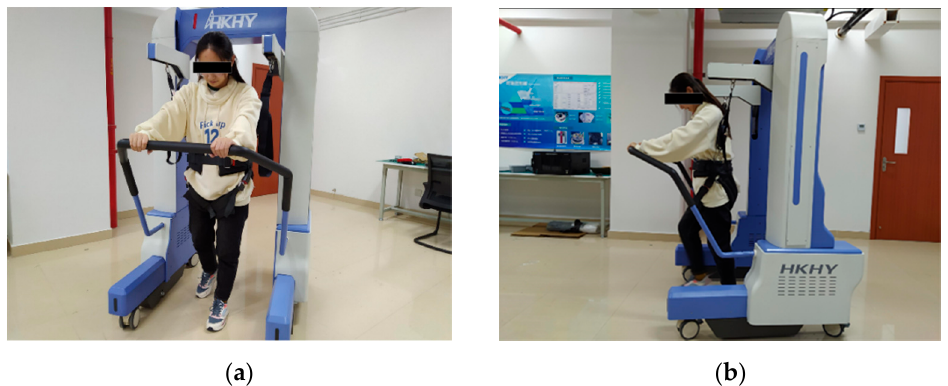
Figure 18. ( a ) The experiment of turning and walking; ( b ) the experiment of straight walking. Straight-line walking training with the help of rehabilitation robots is the main form of rehabilitation for the patients. In the control system, if the displacement difference between the left and right sides is greater than 20 mm, then the robot adopts a steering motion. If it is less than 20 mm, then the robot performs a linear motion. The straight-line walking experiment is conducted assuming that the initial weight support is unchanged.